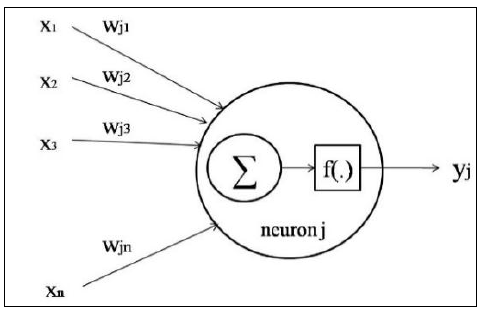
Figure 4. Architecture of an MLP neural network.